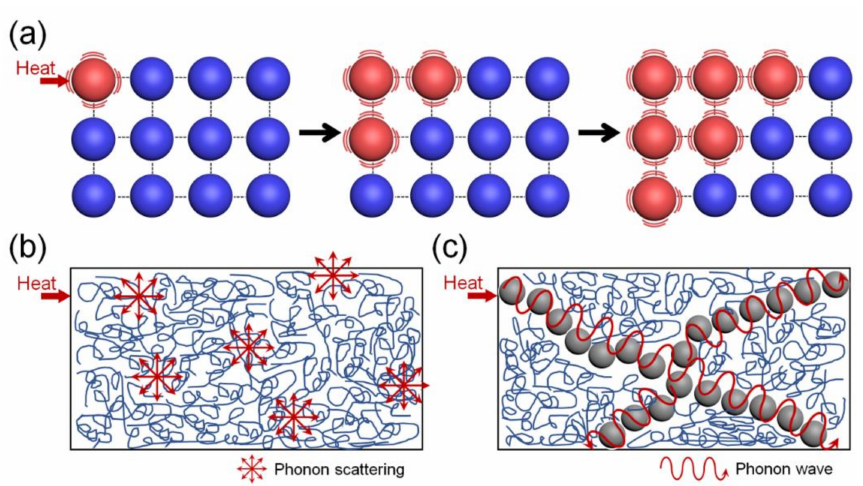
Figure 1. ( a ) Mechanism of thermal conduction in a crystalline material. Schematic diagrams of heat transfer in ( b ) a pure polymer and ( c ) a polymer filled with a thermally conductive